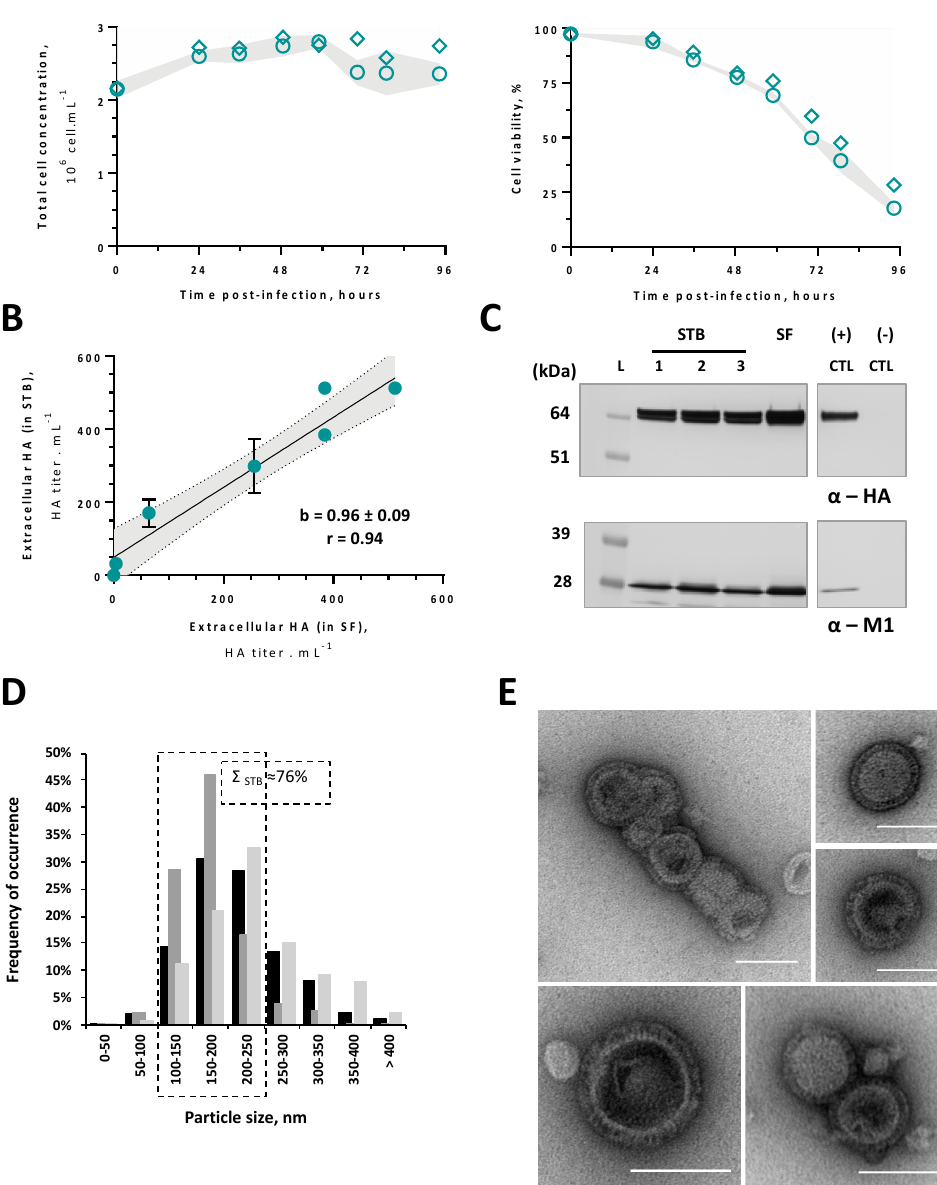
Figure 4. Production of influenza VLPs at a 0.5 L bioreactor scale. ( A ) Cell growth and viability kinetics upon infection in three stirred-tank bioreactors (STBs, circles) and one control shake flask (SF, diamonds), with the grey band representing standard deviation (relative to three biological replicates, n = 3) from STB cultures; ( B ) comparison of extracellular HA titers throughout infection between STB and SF, with straight line representing the best linear fit to the data (r—Pearson’s correlation, m—regression slope) and the grey band representing a 95% confidence level. Data are expressed